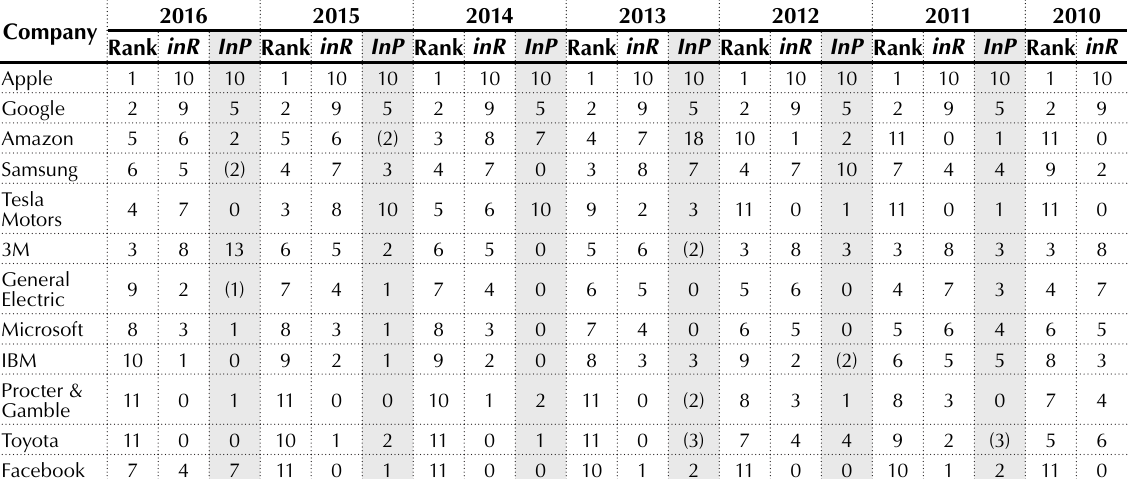
Table 2. The rank (Rank), the normalized Rank ( inR ) and the Innovation Power ( inP )